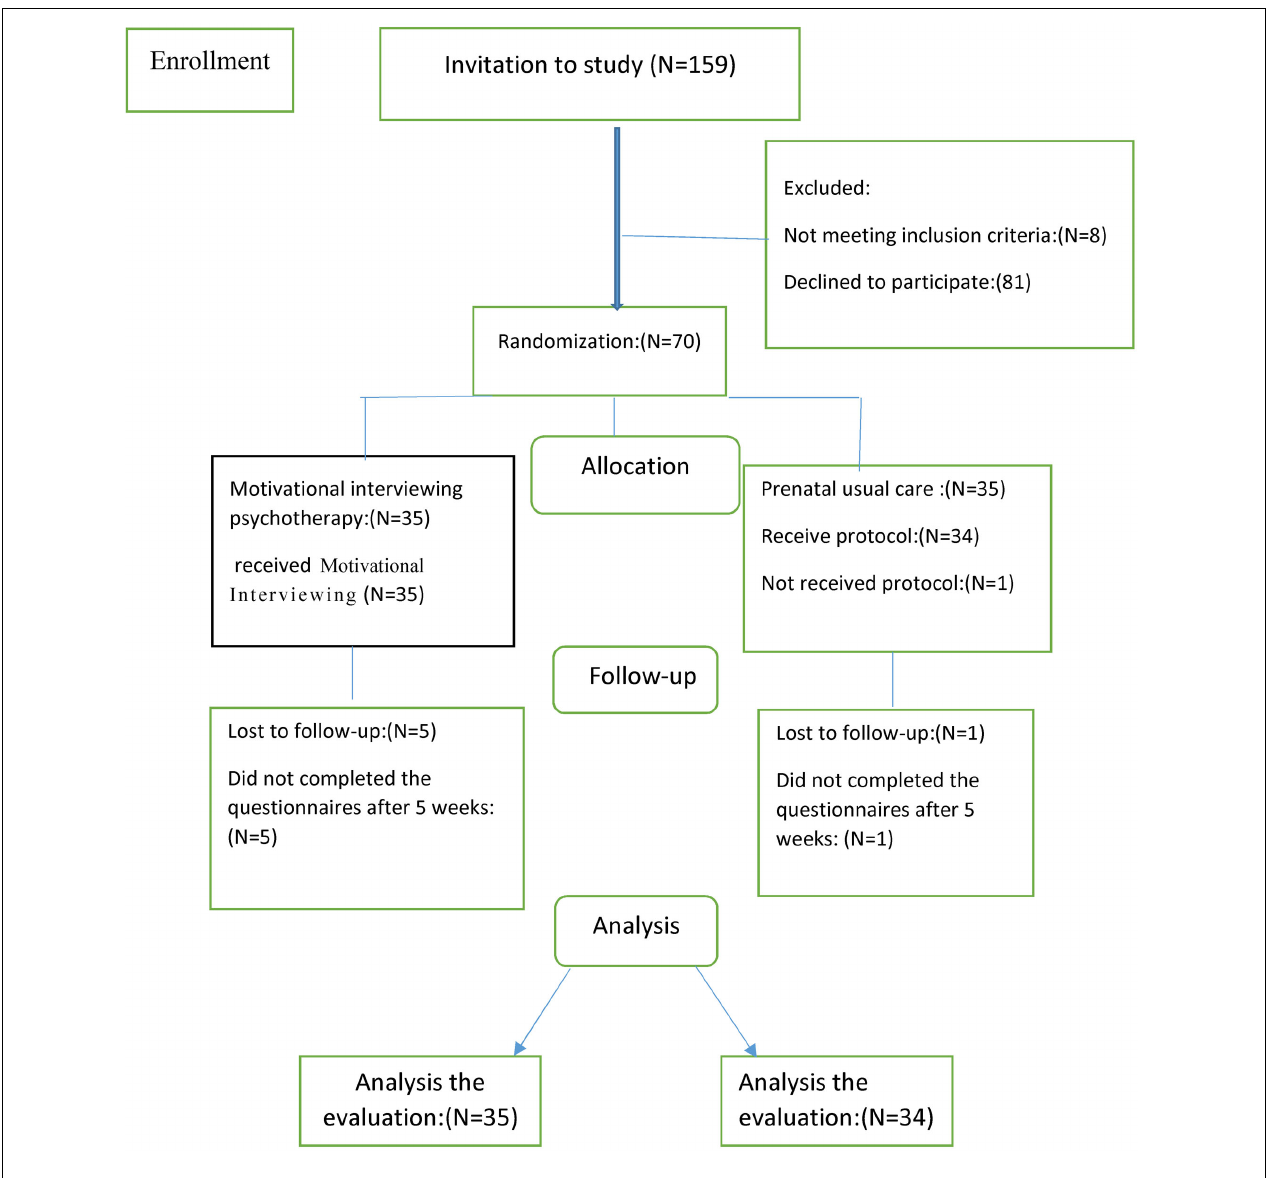
FIGURE 1 | Consort flow diagram of the